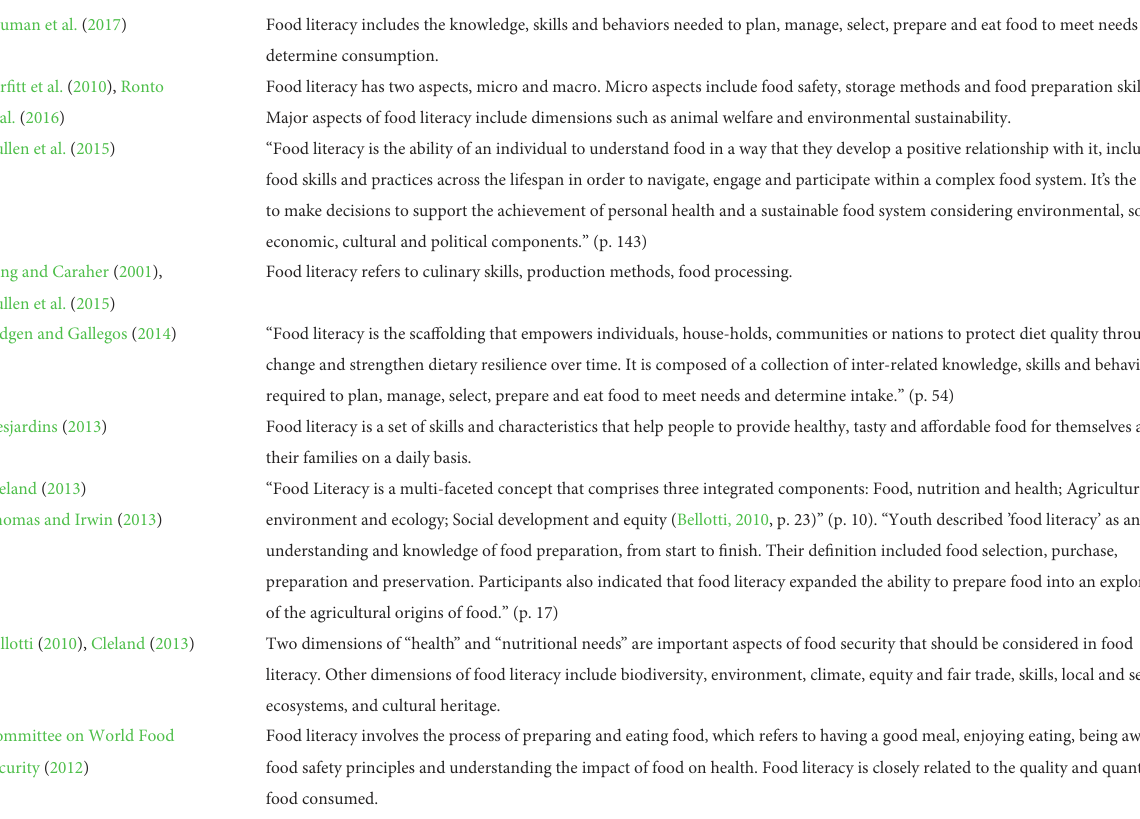
TABLE 1 Food literacy